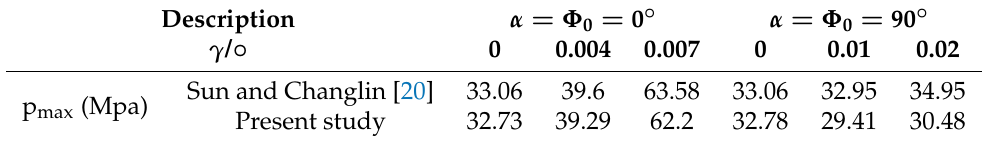
Table 5. Maximum pressure taking into consideration the misalignment